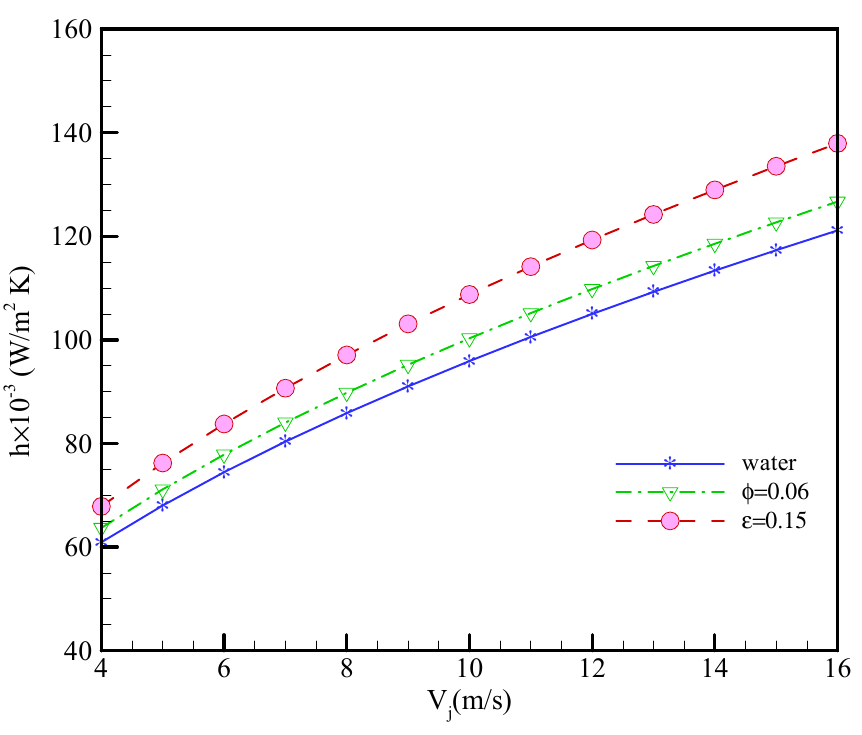
Figure 13. Comparison of the heat transfer coefficients for water, nanofluid, and NEPCM slurry jets as a function of jet velocity.